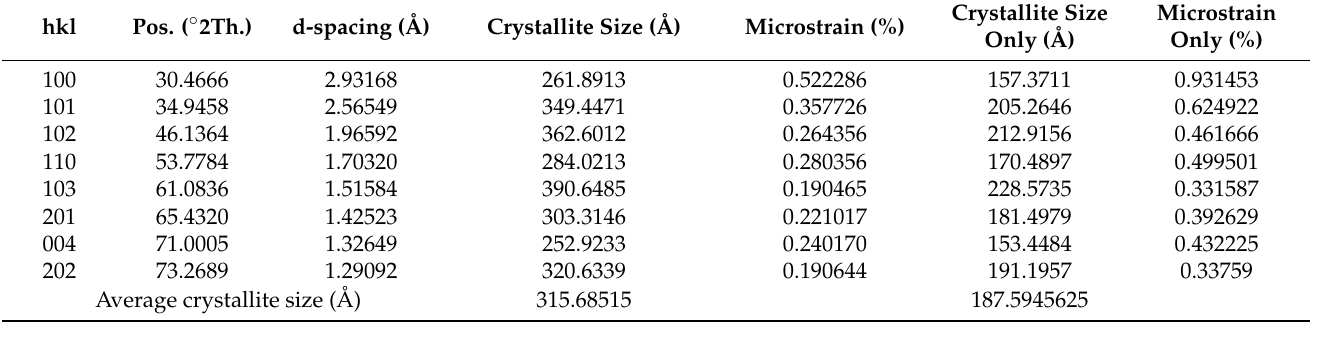
Table 2. Representative crystallographic X-ray diffraction data for NiS nanoparticles.